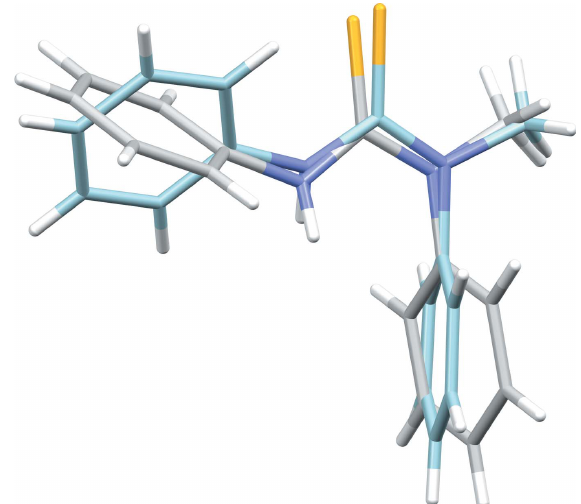
Figure 2 Fit of the first (grey) and second (light blue) molecule in the asymmetric unit of 2 , showing an r.m.s.d. of 1.174 A˚ .